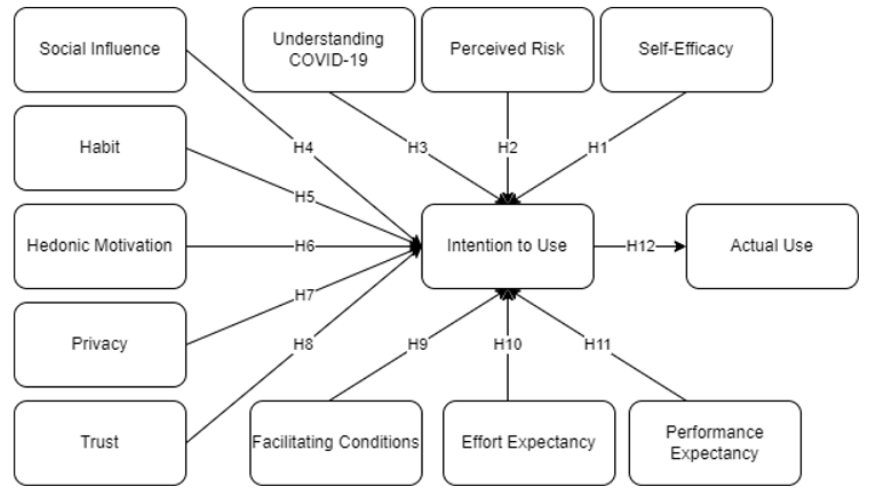
Figure 1. Theoretical Framework.